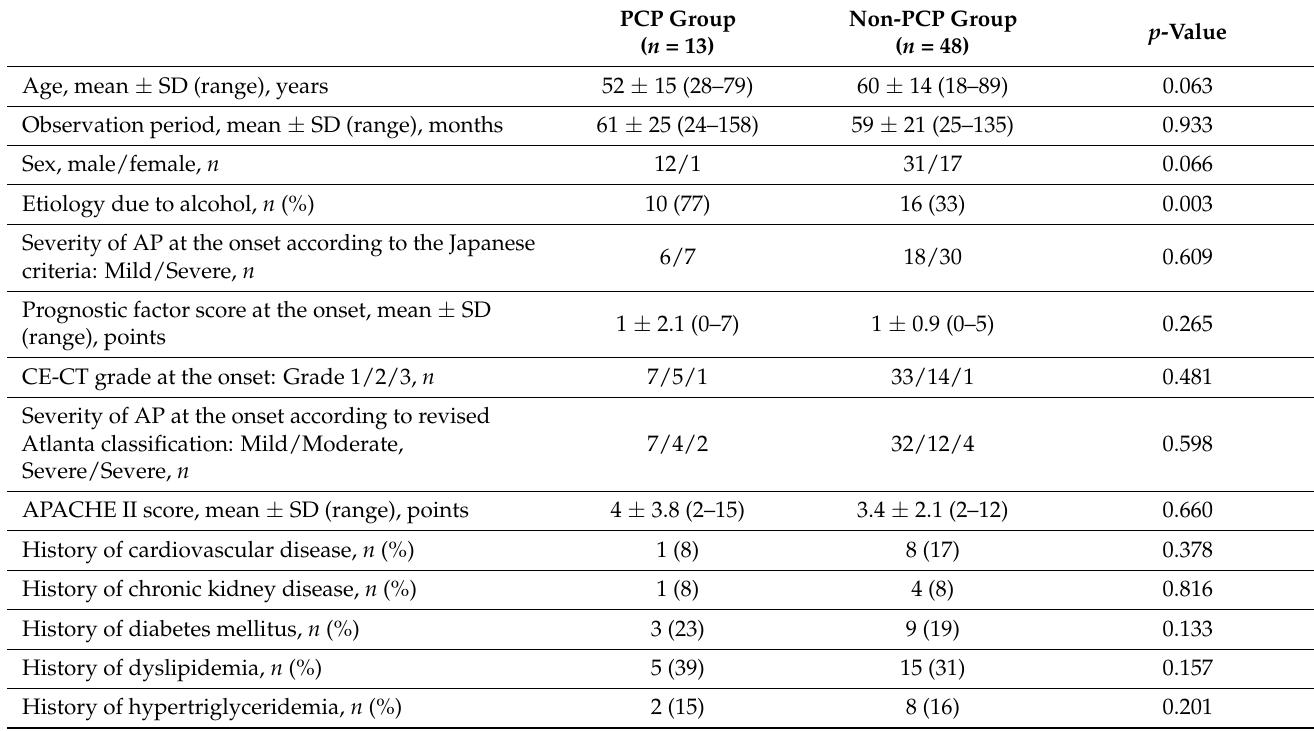
Table 2. Comparison of patient characteristics between PCP and non-PCP